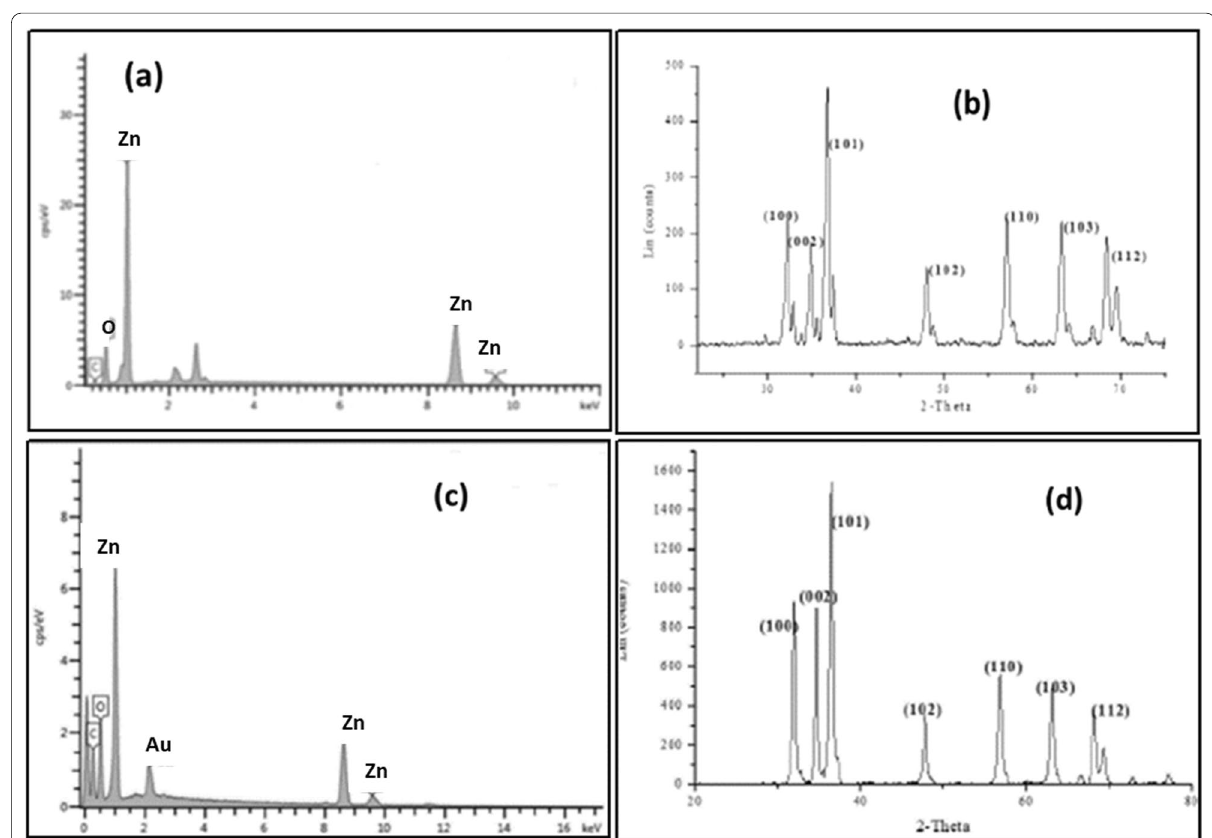
Fig. 5 EDX spectra and PXRD diffraction patterns of ZnONPs synthesized using H. aureonitens extract ( a , b ) and flavone ( c , d